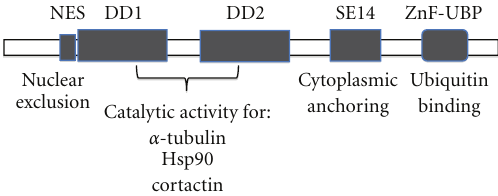
Figure 1: HDAC6 functional domains. The only HDAC with two tandem catalytic domains, deacetylase domains (DD1 and DD2). Tubulin, Hsp90, and cortactin have been found to be HDAC6 substrates. The nuclear export signal (NES) prevents accumulation of the protein in the nucleus and the Ser-Glu- containing tetrapeptide (SE14) region ensures a stable anchorage of the enzyme in the cytoplasm. The linker between both DDs is able to bind dynein and the high a ffi nity ubiquitin-binding zinc finger domain